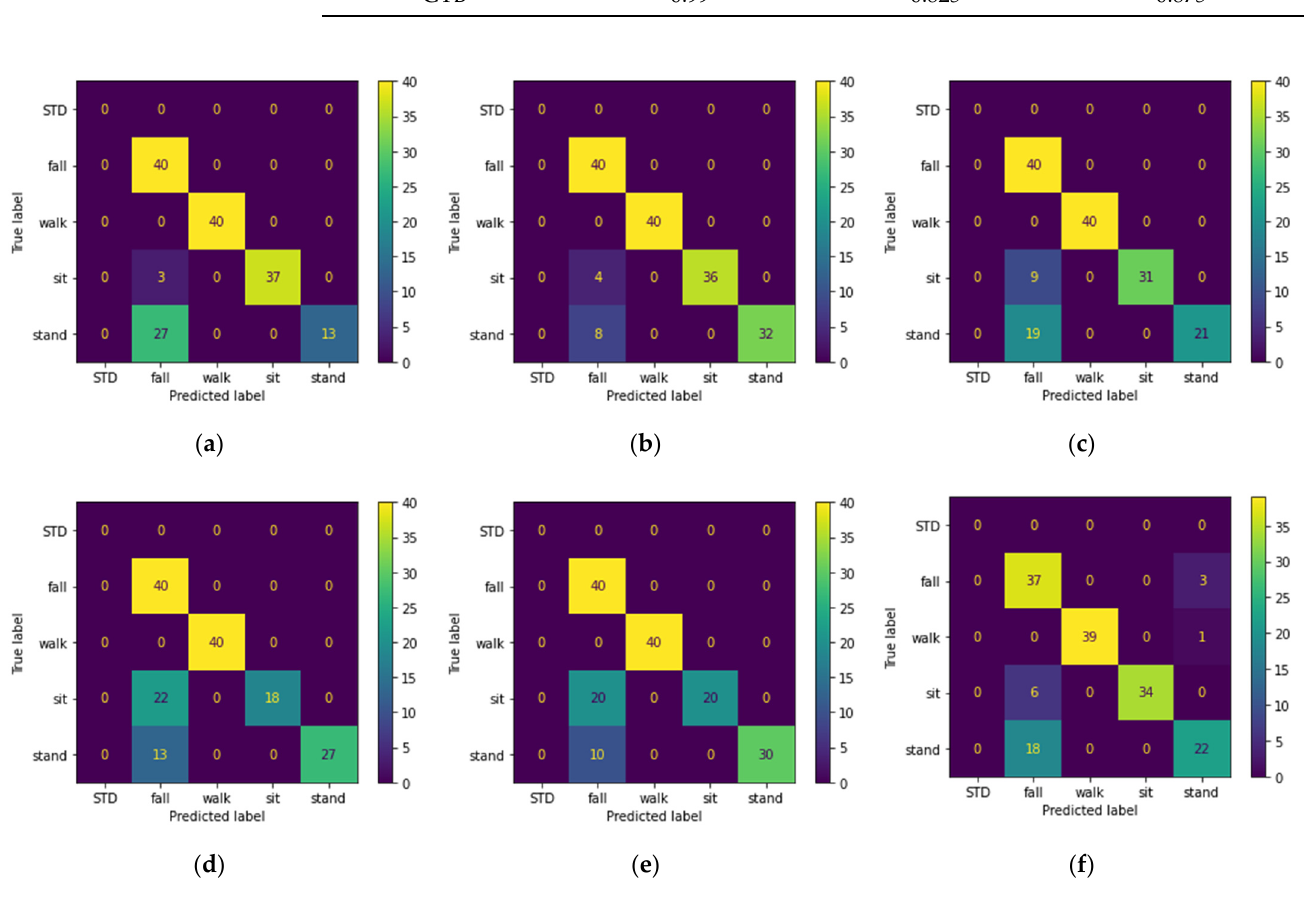
Figure 5. Confusion matrix of the activities in the unseen dataset predicted using: ( a ) MLP; ( b ) SVM; ( c ) Random Forest; ( d ) ERT; ( e ) KNN; ( f ) GTB; classifiers trained with top PCA components extracted from Doppler shift feature of the train dataset.